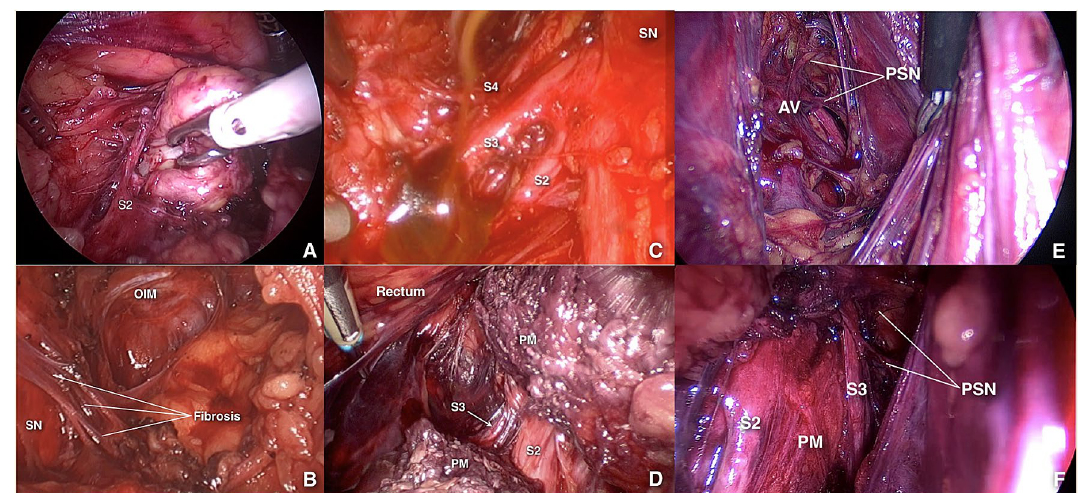
Figure 2. The five etiologies of intrapelvic nerve entrapment: neoplastic ( A ), fibrotic ( B ), endometriotic ( C ), abnormal piriformis muscle bundle originating medially to the sacral foramina ( D ) and neurovascular conflict before ( E ) and after ( F ) decompression. SN sciatic nerve; PM pyriformis muscle; OIM obturator internus muscle; PSN pelvic splanchnic nerves; AV abnormal